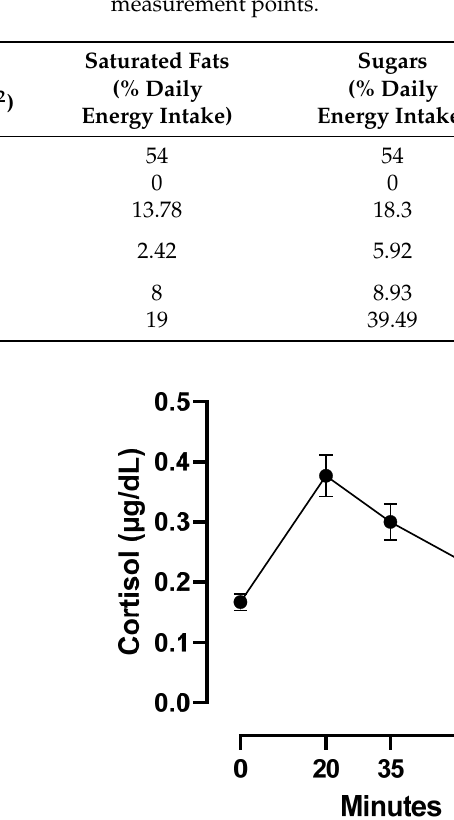
Table 1. Descriptive statistics for Body Mass Index (BMI), Saturated Fats, Sugars, and the four cortisol measurement points.